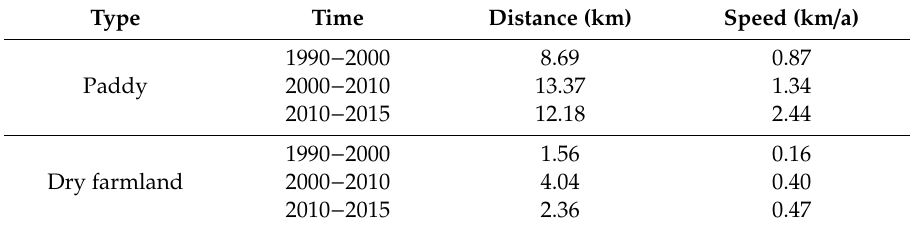
Table 5. Historical changes in migration distance and speed of gravity center.